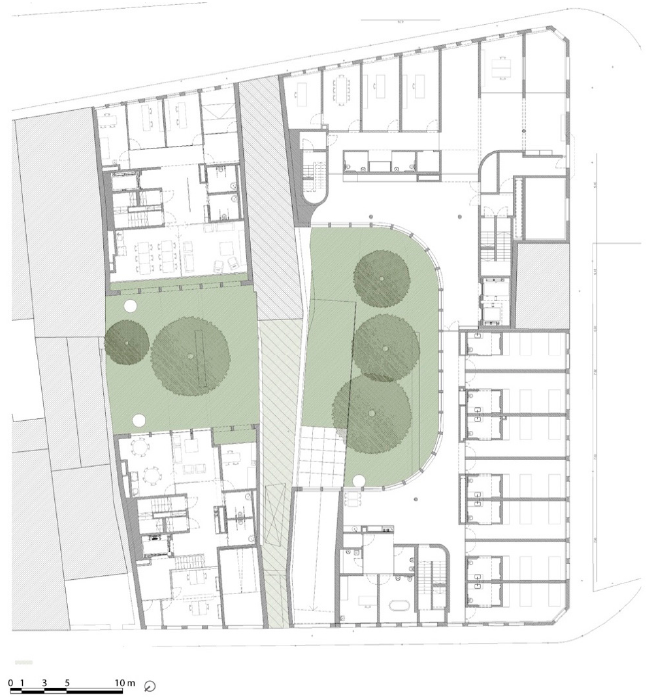
Figure 14. Braga. Ground-floor plan.